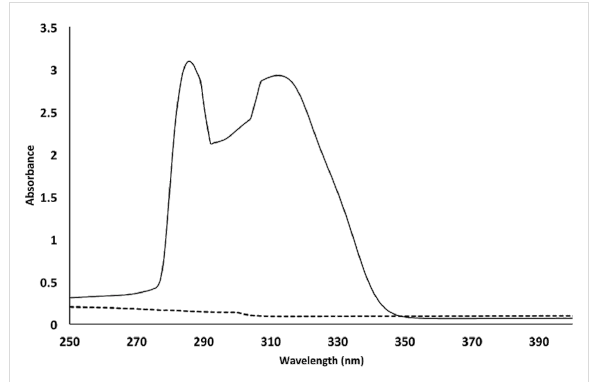
Figure 3: UV − vis spectra of DAG 6a (dotted line) and conjugated DAGs 10a and 10a’ as a mixture ( 10a / 10a’ 72:28) in toluene at a con- centration of 0.5 μ